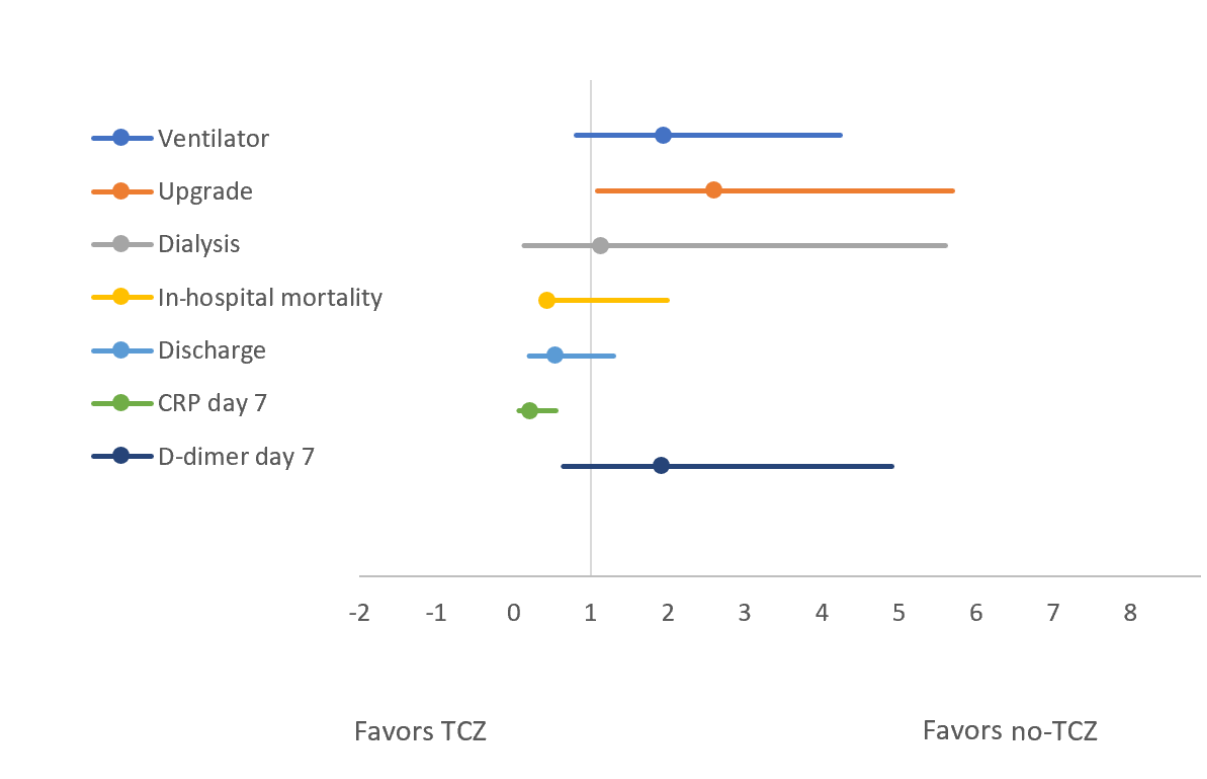
Figure 2. Forest plot comparing unadjusted odds of outcomes between the tocilizumab (TCZ) and no-TCZ groups. CRP: C-reactive